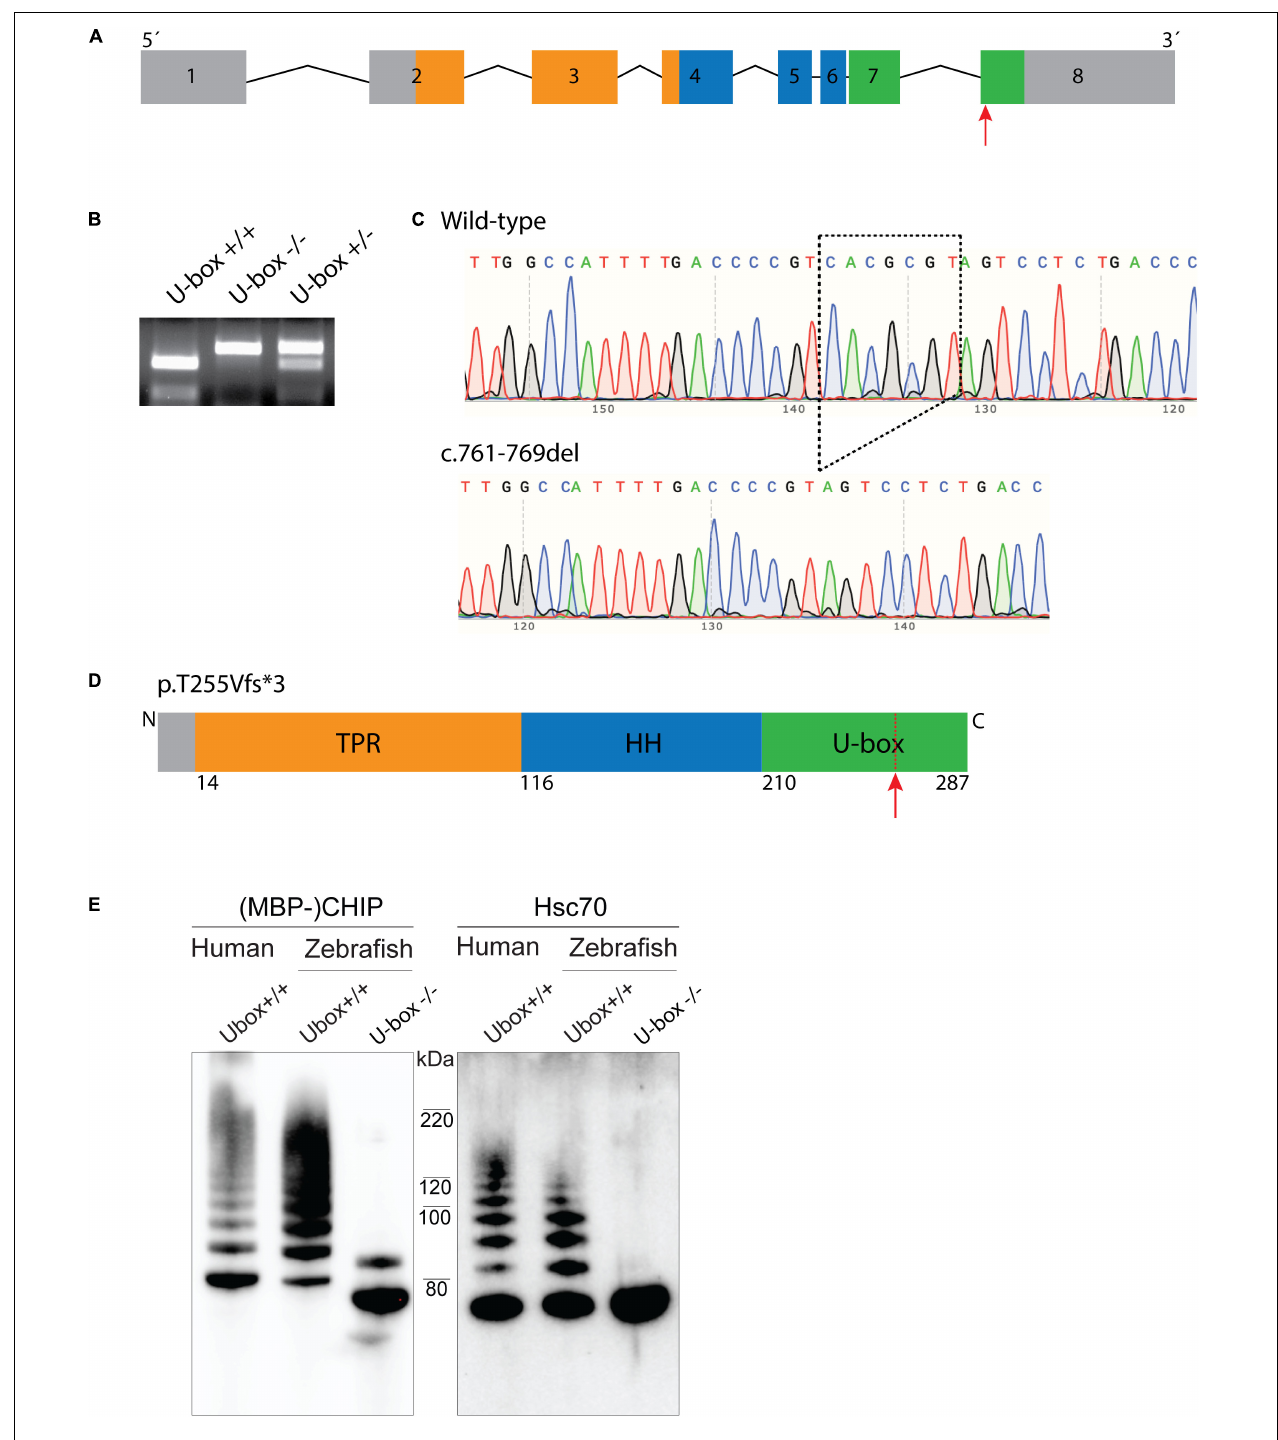
FIGURE 3 | Zebrafish U-box − / − expressing truncated Chip with impaired ubiquitin ligase activity were generated by CRISPR/Cas9. Zebrafish stub1 gene was targeted for mutagenesis at the last exon (A) , leading to an introduction of 7 bp-deletion mutation in this exon (c.761-769del) which was detected by Mlu I restriction digestion (B) and DNA sequencing (C) . The 761-769del mutation is predicted to result in a frameshift and early stop codon and truncation of C-terminal U-box domain (D) . Recombinant Chip proteins were produced from the cDNA of U-box − / − and wild-type zebrafish, and further examined for in vitro ubiquitin ligase activity on Chip ( E , lane 1–3) and Hsc70 substrates ( E , lane 4–6). Compared to the wild-type human CHIP ( E , lane 1 and 4) and wild-type zebrafish Chip ( E , lane 2 and 5) controls, U-box truncated zebrafish Chips showed impaired self-ubiquitination ( E , lane 3) and Hsc70 ubiquitination activities ( E , lane